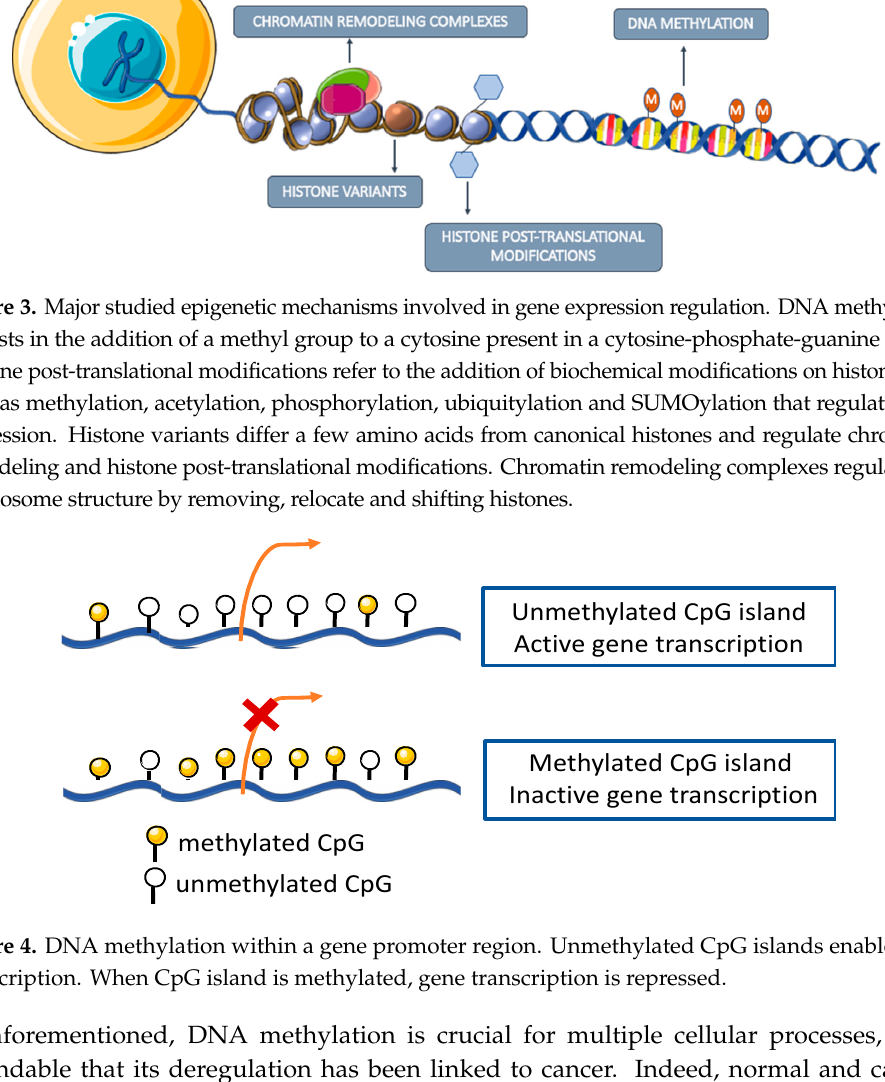
Figure 3. Major studied epigenetic mechanisms involved in gene expression regulation. DNA